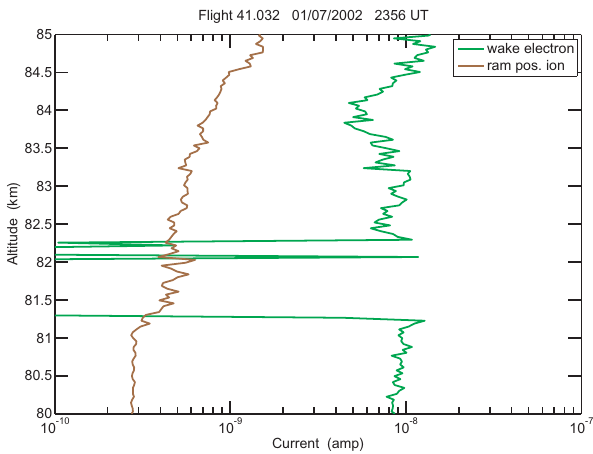
Fig. 13. Comparison of electron and positive ion Langmuir probe currents during the downleg portion of Flight 41.032 (1 July 2002, 23:56 UT).